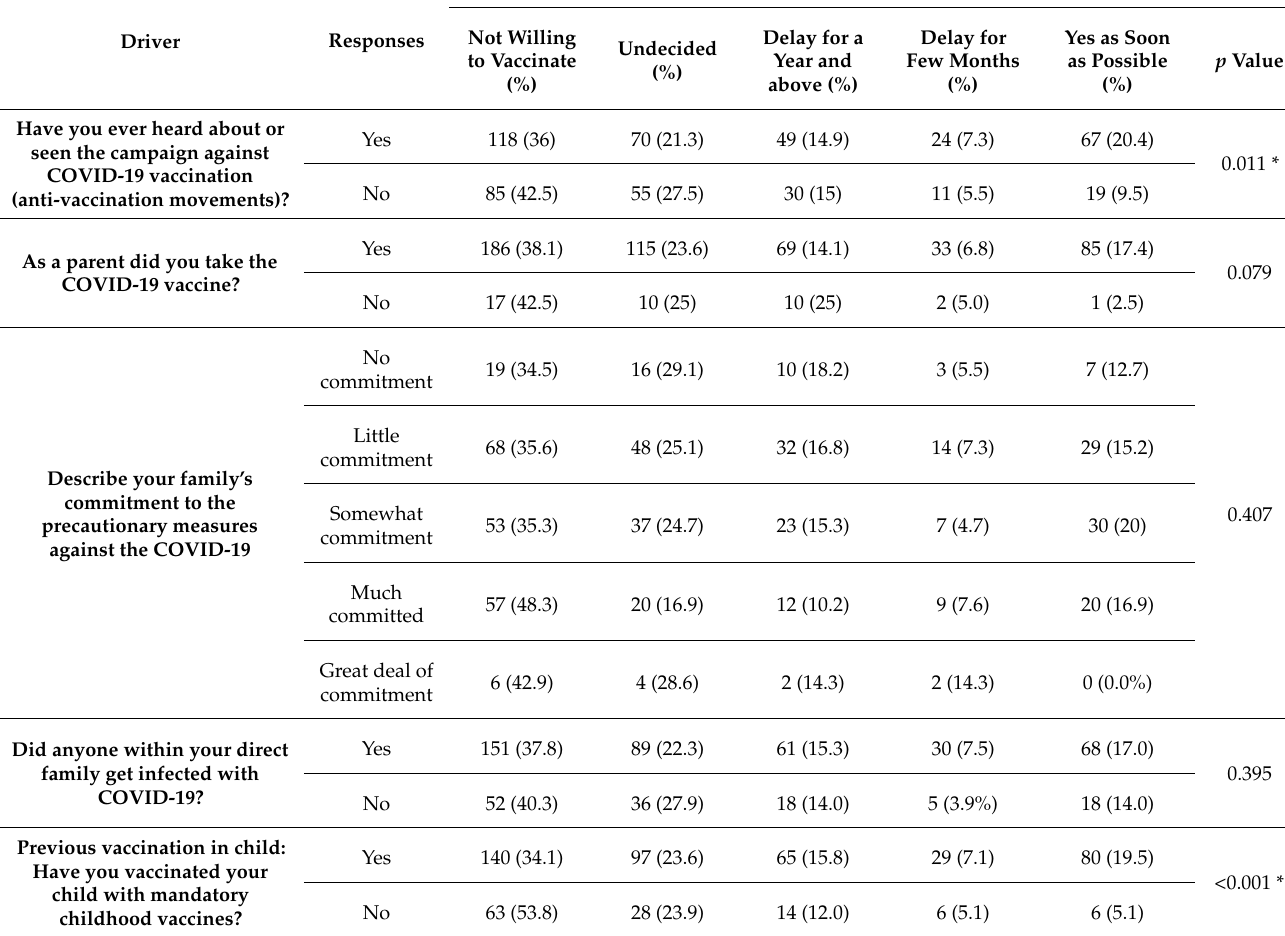
Table 4. Drivers of parental COVID-19 vaccine hesitancy for their children, drivers of parental willingness to vaccinate their children against COVID-19, or factors influencing parents’ willingness to vaccinate their children against